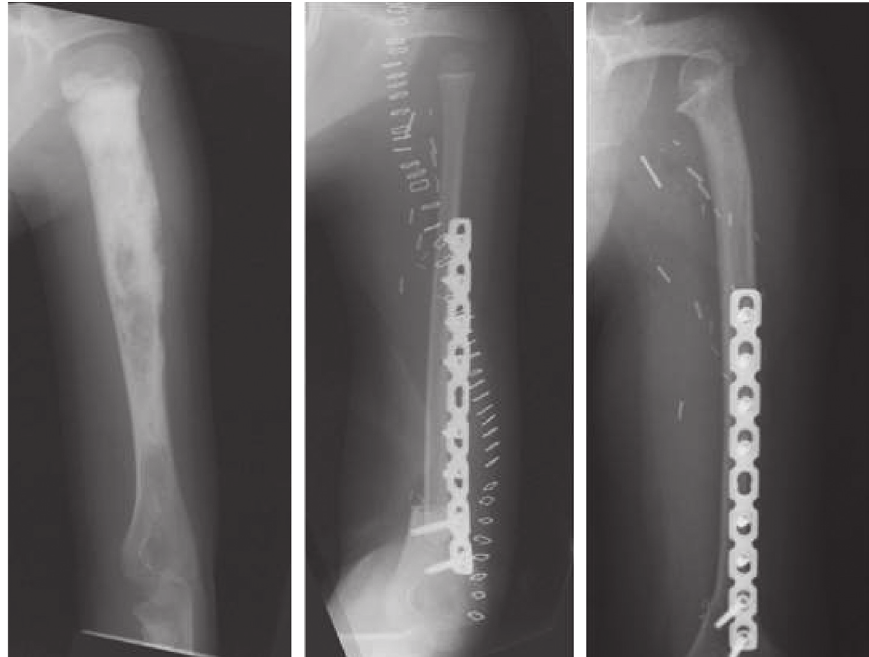
Figure 1: A FVFG (free vascularized fibular graft) is used to replace proximal humerus in a young growing patient who underwent massive resection to treat a malignant bone tumor. The proximal growing plate of the fibula allowed the autograft to increase its length, mimicking the growth of the native proximal